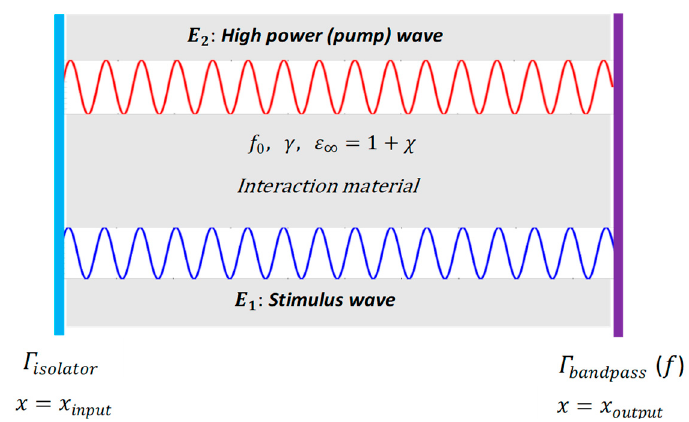
Figure 3. Configuration of the cavity.